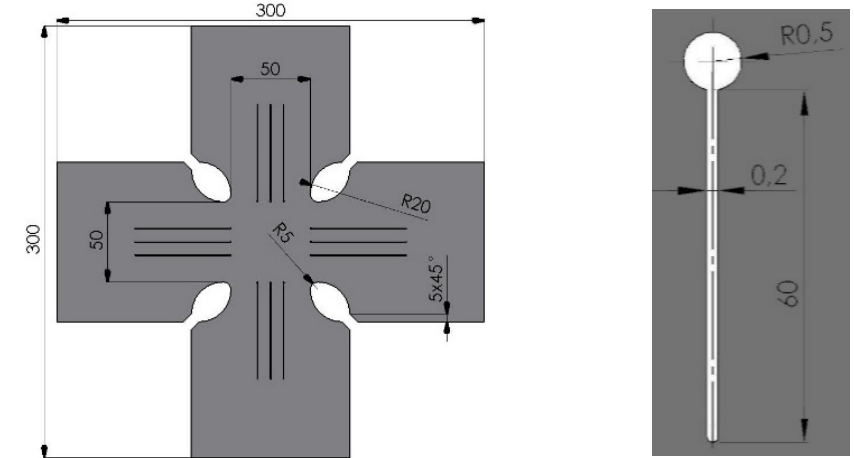
Figure 14. The shape of the cruciform specimen and its design parameters.